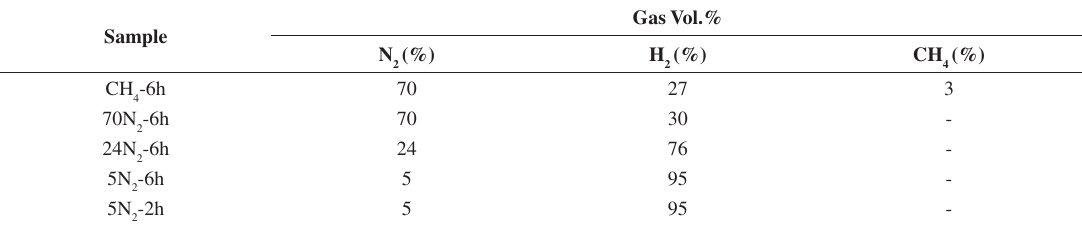
Table 2. Gas mixtures for the nitriding batches.